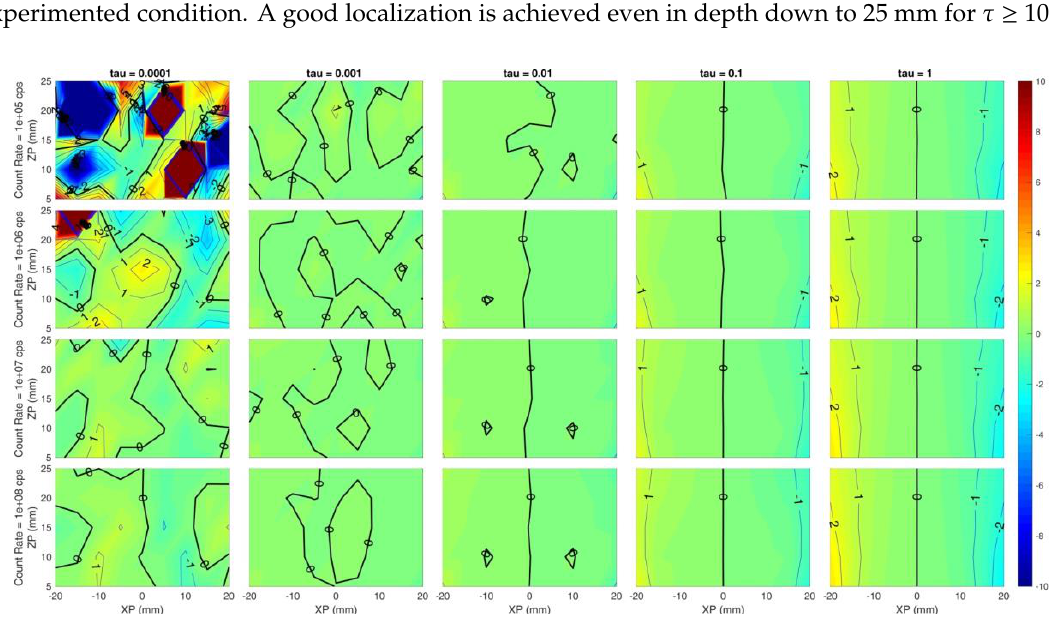
Figure 3. Localization error on the x coordinate (expressed in mm) at different values of 𝜏 (columns) and count rates (rows). Horizontal axis of each subplot is the simulated x position of the inclusion and vertical axis is the simulated z position. Colors show an error of − 10 mm (blue) to +10 mm (red). The same considerations apply to the localization along the y coordinate (data not shown).